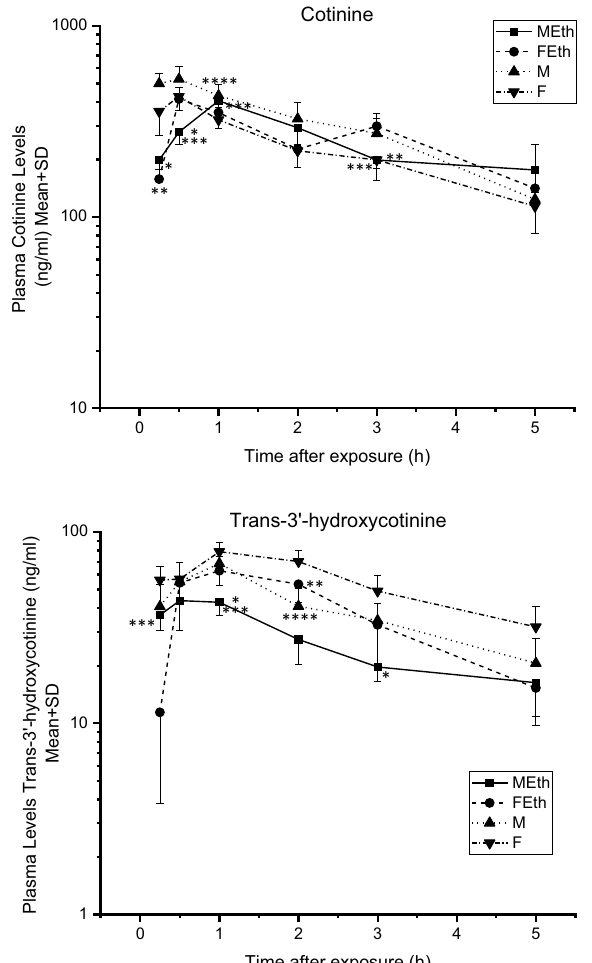
Figure 5. Plasma cotinine and trans-3’-hydroxycotinine levels measured over time—rats exposed to tobacco smoke at a concentration, expressed as carbon monoxide, 1500 mg CO/m 3 for 5 days, 6 h a day. Asterisks indicate a significant difference value (P < 0.05): *MEth vs M, **FEth vs F, ***MEth vs Feth and ****M vs